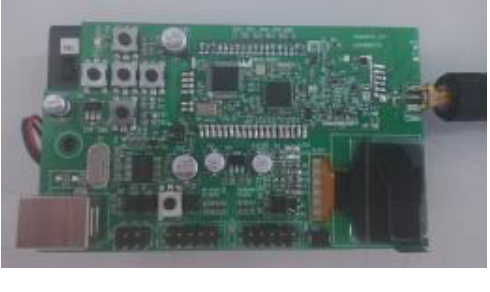
Figure 19. CSS node.